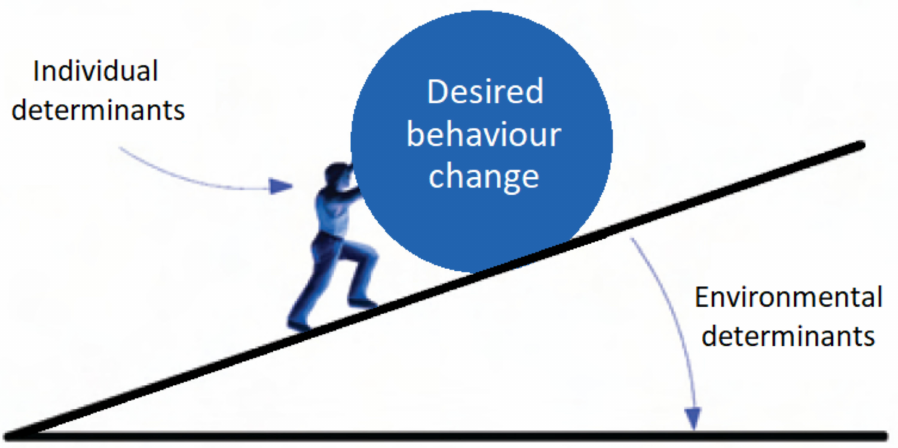
Figure 9. The complex system of the person, ball and